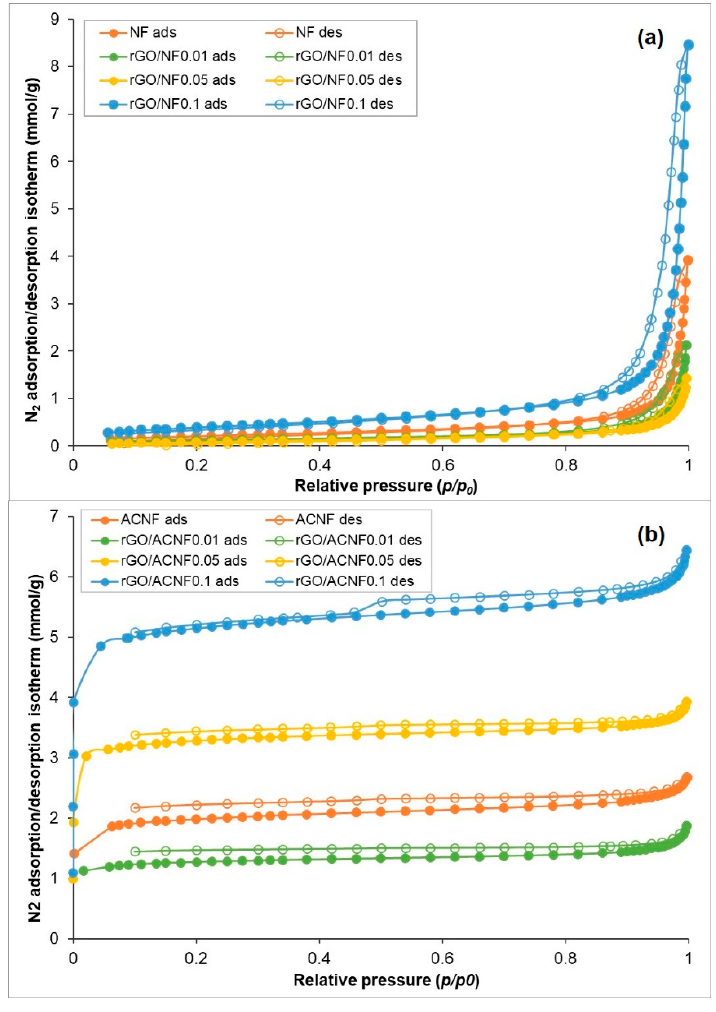
Figure 2. N 2 adsorption/desorption isotherms of the materials under investigation ( a ) materials before activation and ( b ) materials after activation. Table 1. Porous characteristics of the pristine nanofibers (NF) and reduced graphene oxide (rGO) / NFs nanocomposites before and after